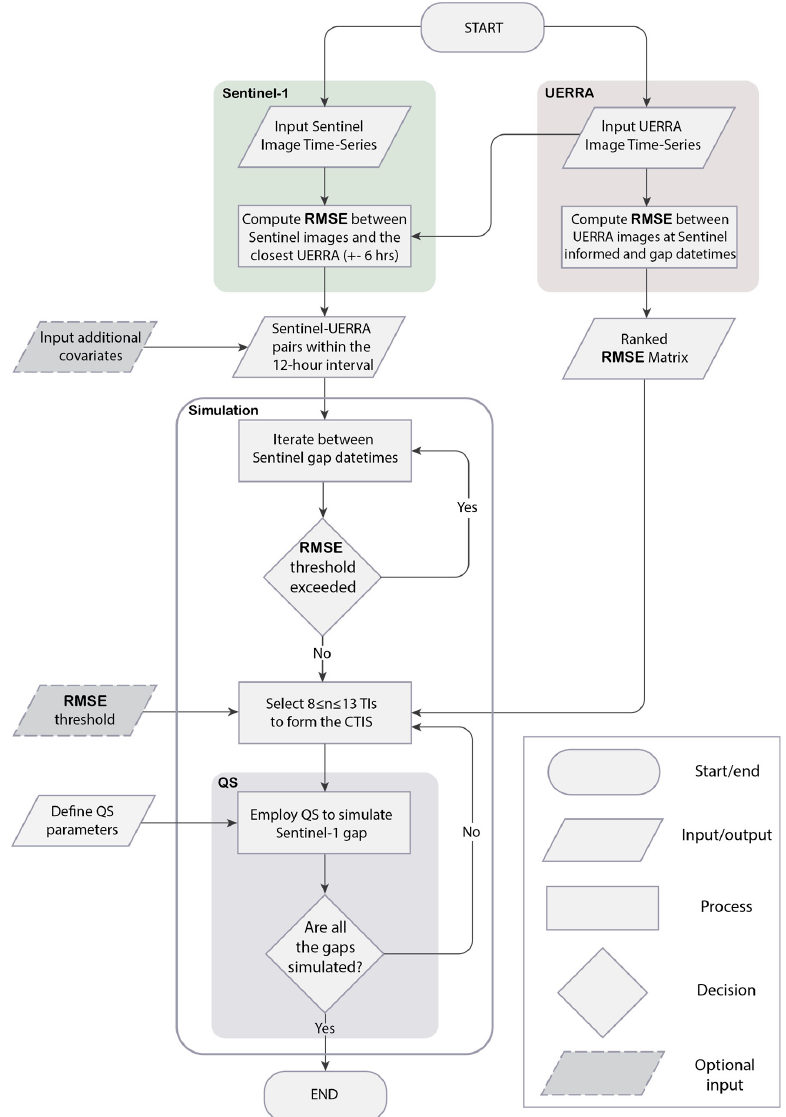
Figure 4. Methodological workflow.